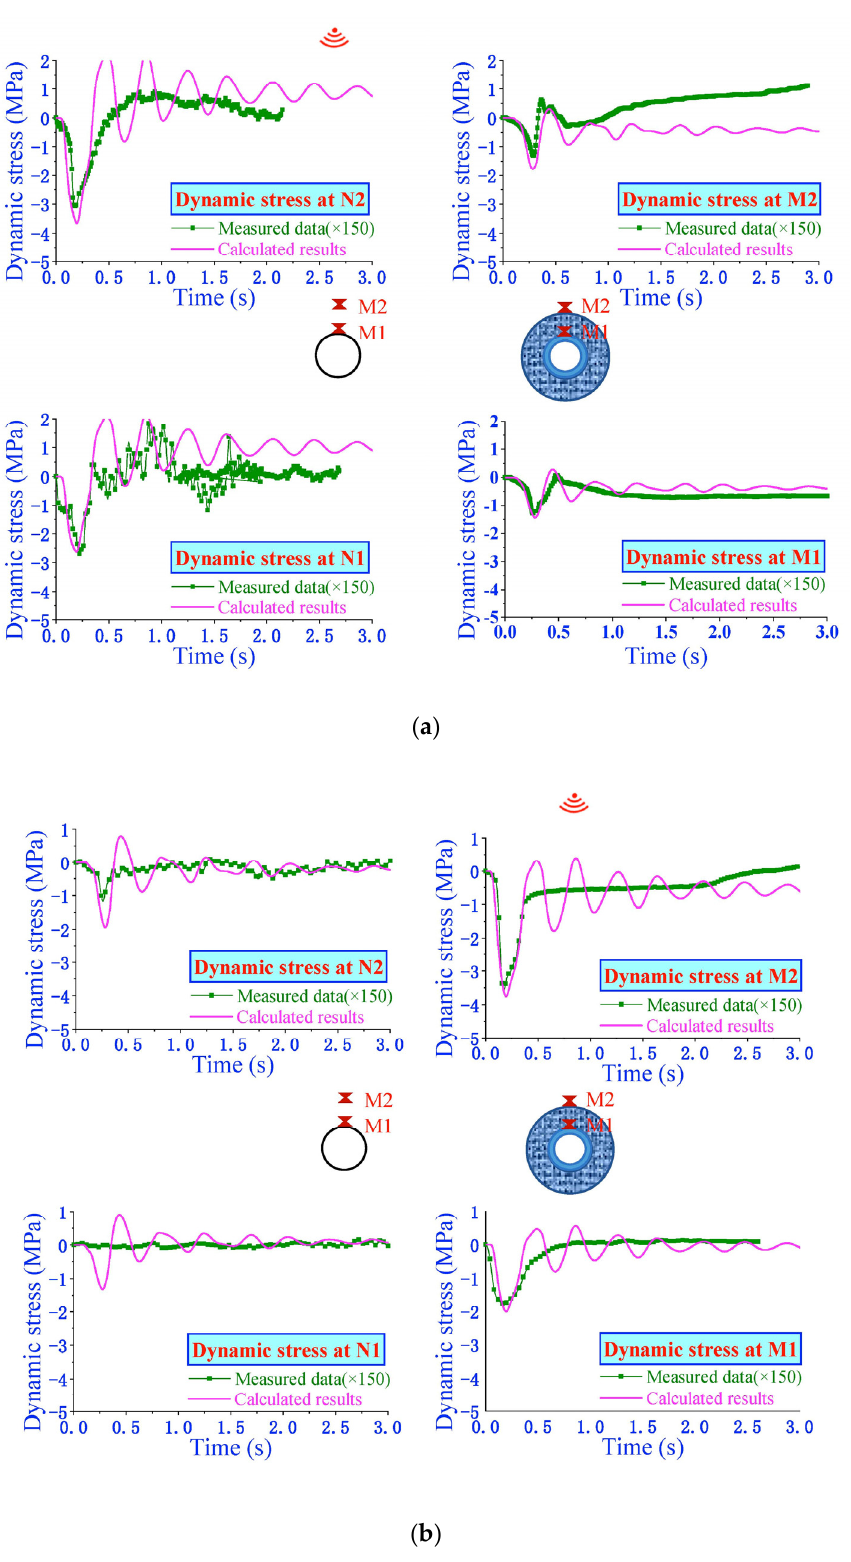
Figure 4. Experiment and numerical results of vertical dynamic stress induced by impact load of Schmidt hammer from the top right above ( a ) a normal coal roadway and ( b ) a modified coal roadway.